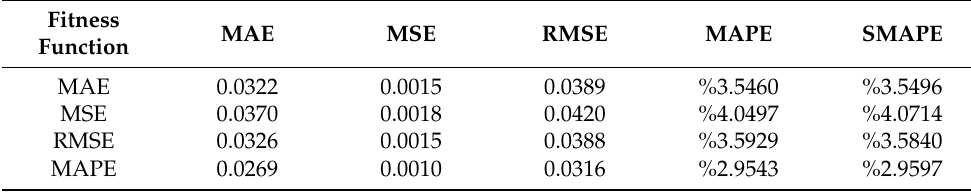
Figure 11 . Fitness graph under different fitness functions Figure 11. Fitness graph under different fitness functions. Table 3. Model performance under different fitness